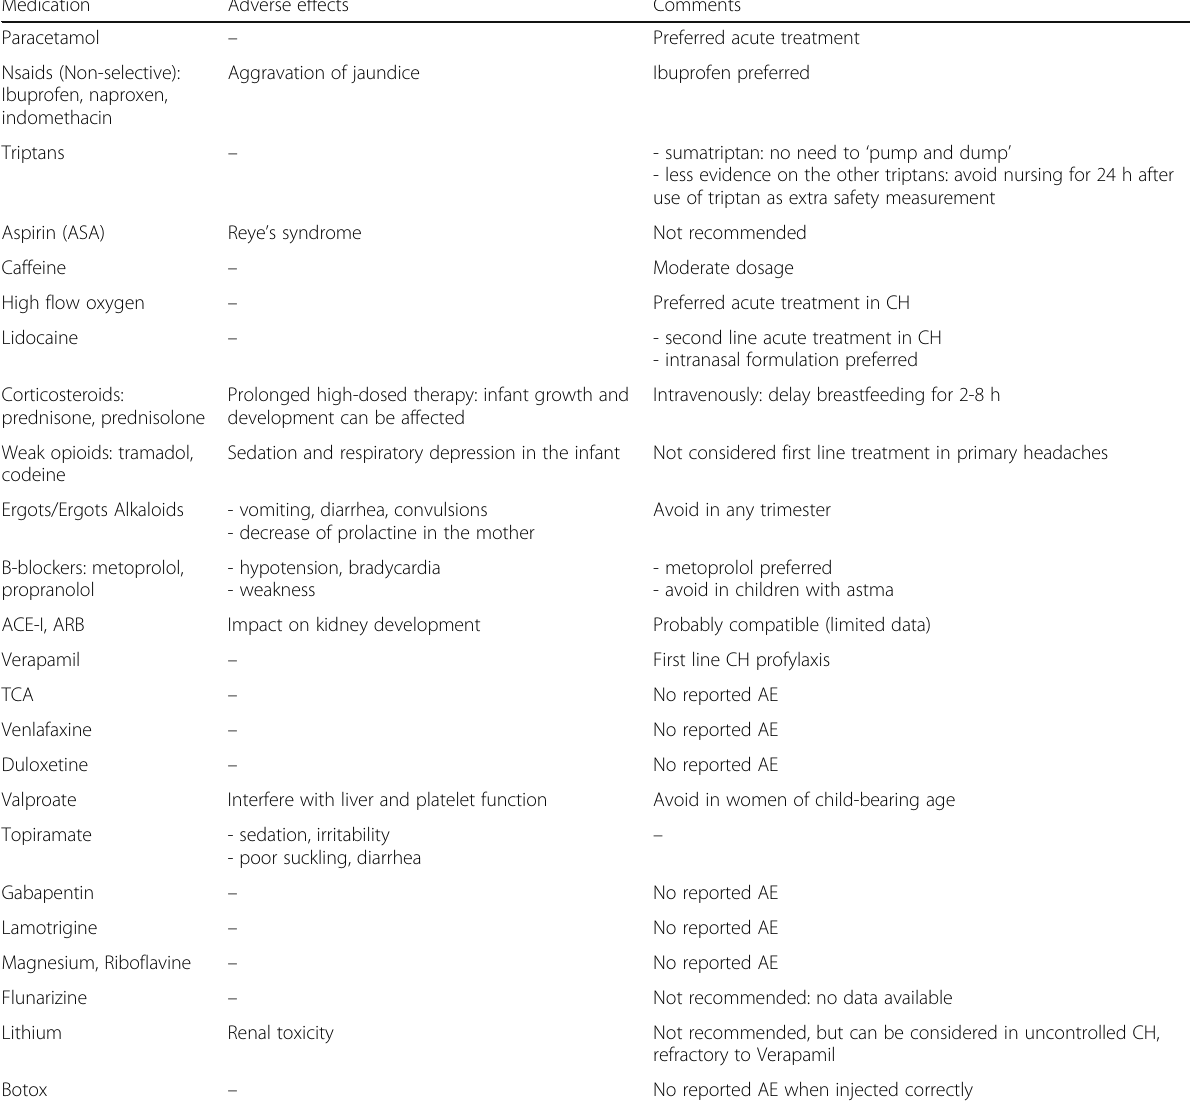
Table 5 Summarizing table on treatment of headache in breatsfeeding women